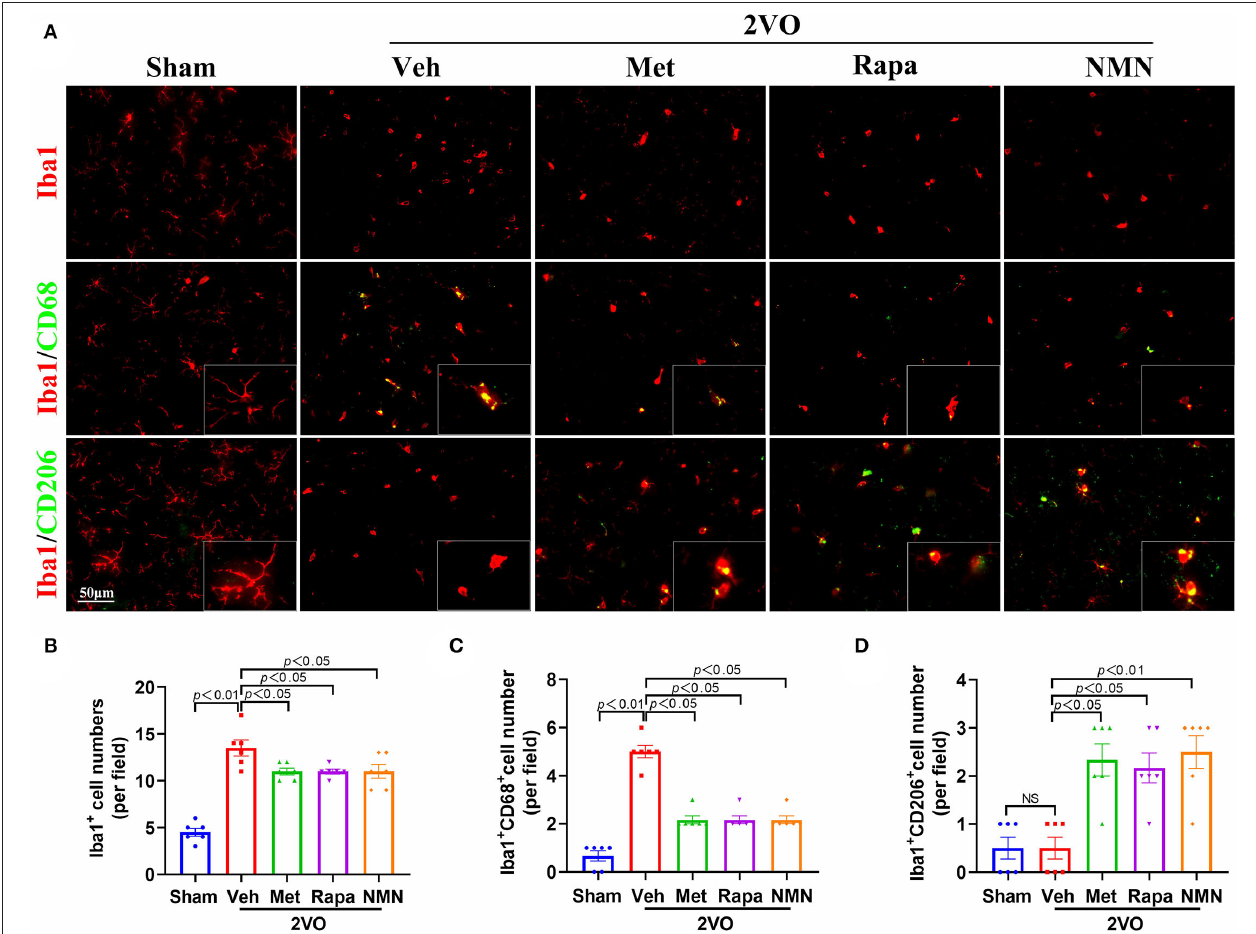
FIGURE 4 | Metformin, rapamycin, or NMN pretreatment suppresses BCCAO-induced microglial response. (A) Representative images of immunostaining of Iba1 + microglia (red, top panel), CD68 + (green, middle panel) and CD206 + (green, bottom panel) in striatum of sham or BCCAO rats pretreated with vehicle (Veh), metformin (Met), rapamycin (Rapa), or NMN (NMN) at 2 weeks before surgery. Quantitative analysis of Iba1 + cells (B) , Iba1 + CD68 + cells (C) and Iba1 + CD206 + cells (D) in striatum in sham or BCCAO rats after pretreatment. The p -values in A were assessed by one-way ANOVA with a Tukey’s test. The p -values in B and C were assessed by Kruskal–Wallis test with a Dunn post-test. All data were shown as mean ± SEM, n = 6 per group. 2VO, two-vessel occlusion; NS, not